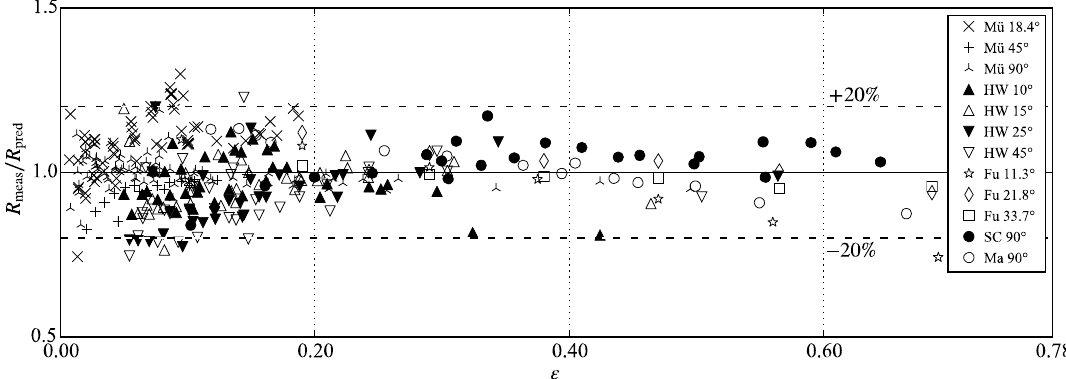
Figure 10. Measured over predicted (Equation (9)) runup height R meas / R pred versus relative wave crest amplitude ε for experiments from data sources from Müller (Mü) [7], Hall and Watts (HW) [14], Fuchs (Fu) [20], Street and Camfield (SC) [21], and Maxworthy (Ma) [19].